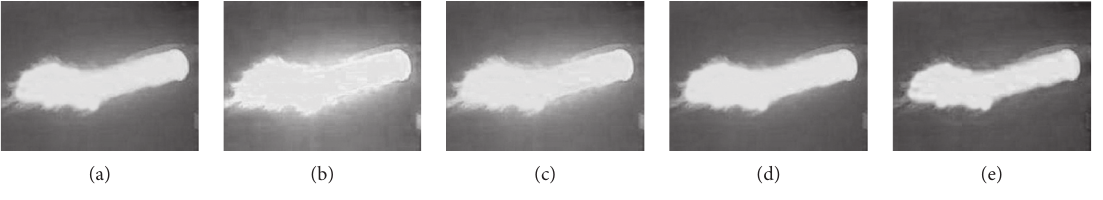
Figure 5: The comparison results of flame image IV under different methods: (a) average method; (b) maximum method; (c) weighted average method 1; (d) weighted average method 2; (e) weighted average method